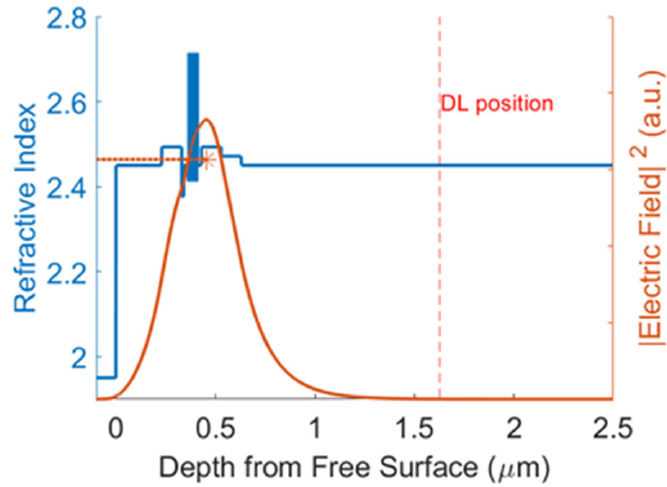
Figure 5. 1D mode simulation of the New SRT structure as listed in Table 1.